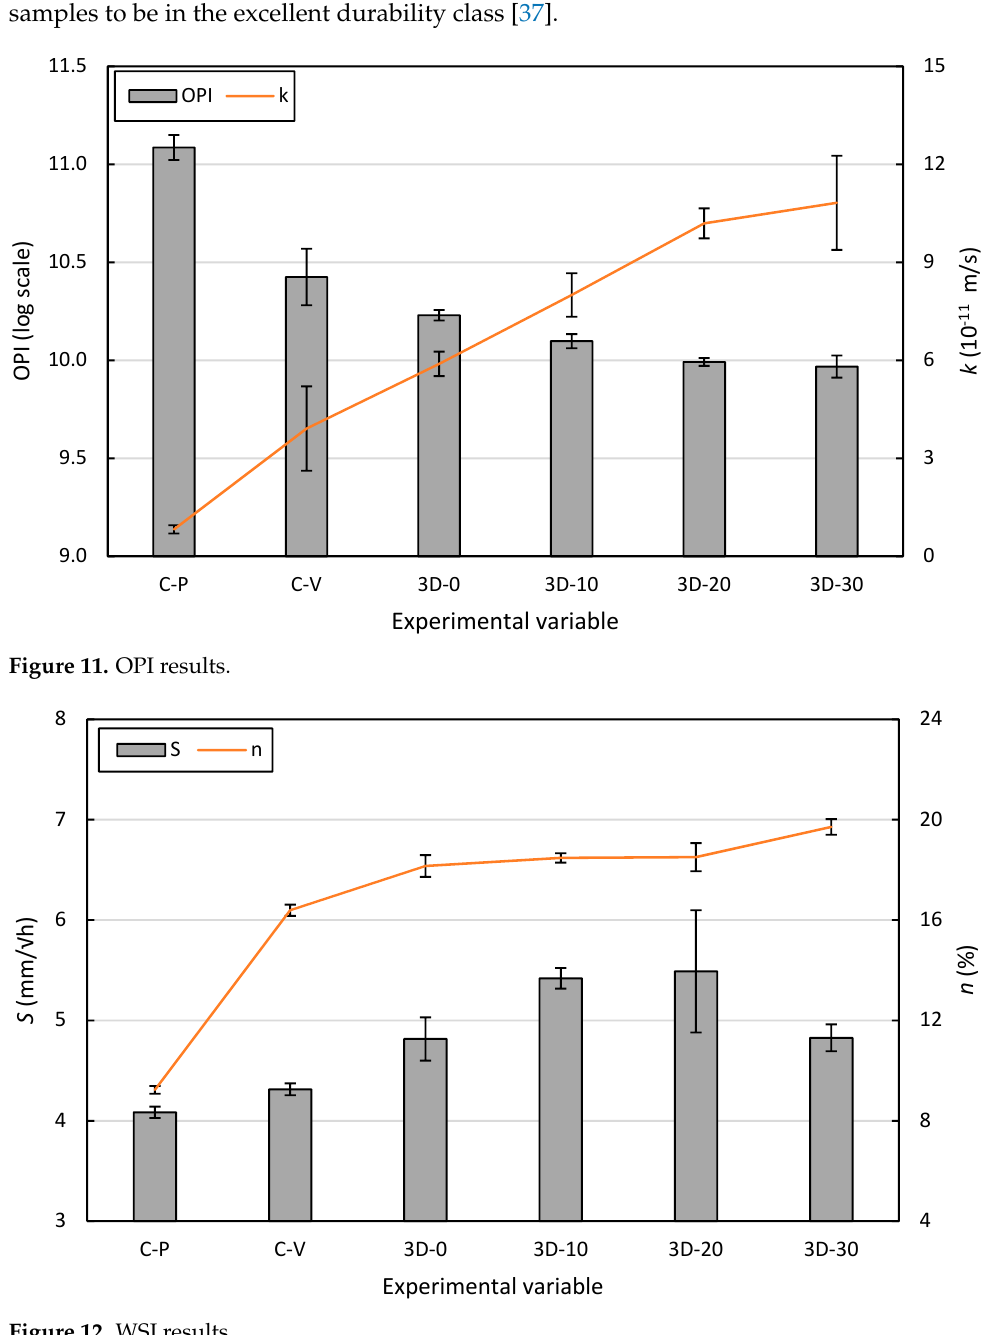
Figure 12. WSI Figure 12. WSI results.